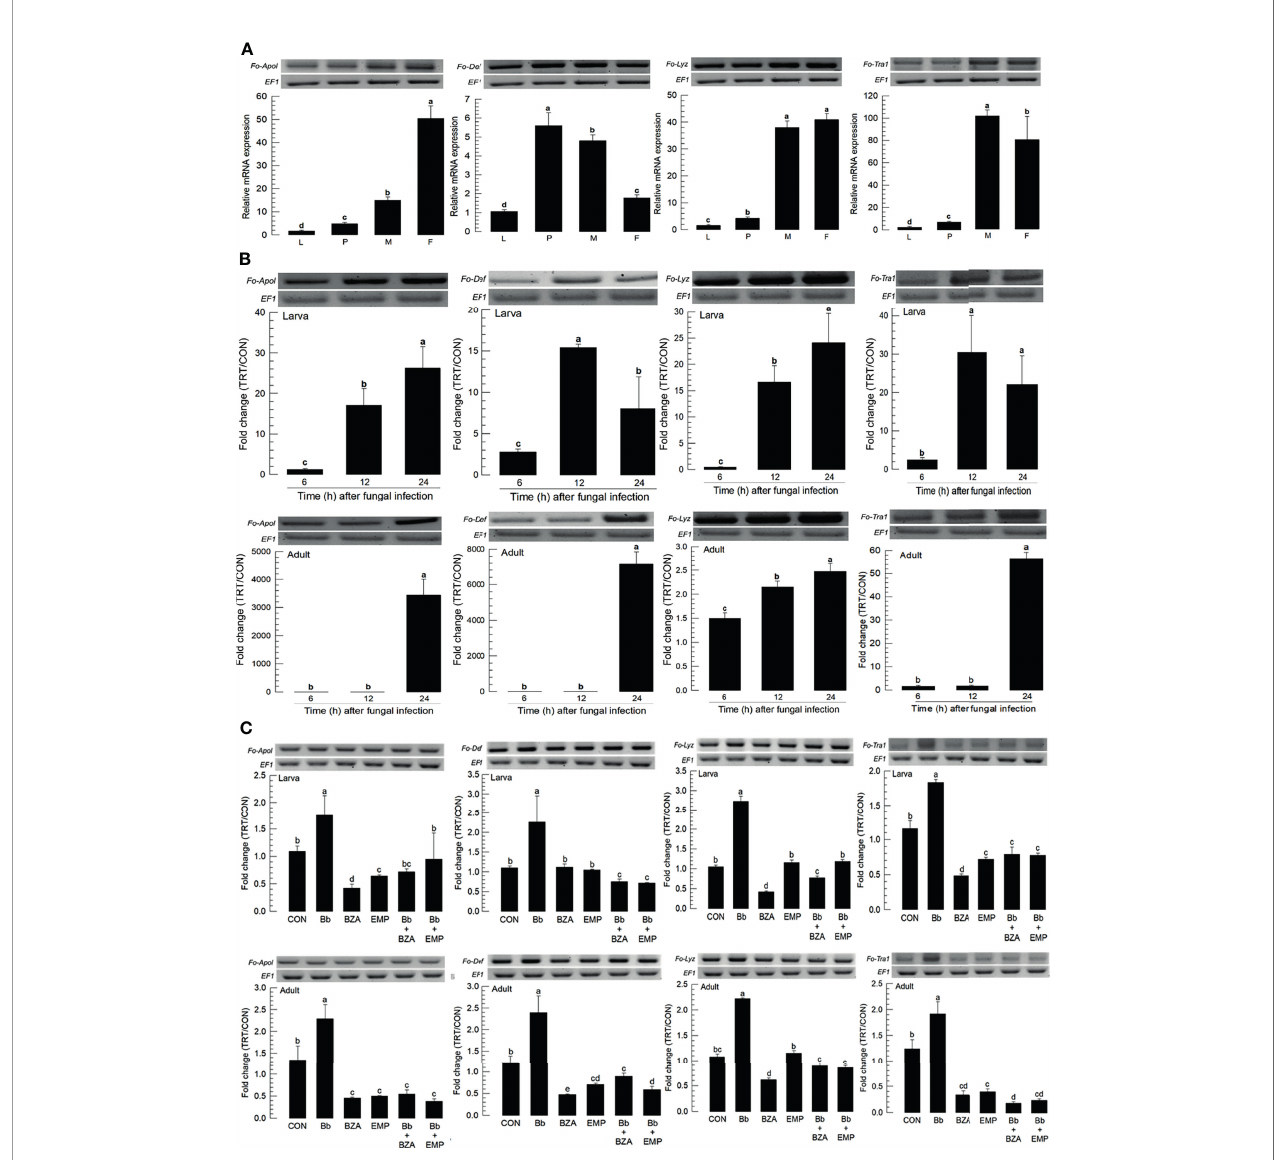
FIGURE 9 | Inhibitory effect of EMP or BZA on the expression of four antimicrobial peptides (AMPs) in F. occidentalis named as Fo-Apol (apolipophorin III), Fo-Def (Defensin), Fo-Lyz (lysozyme), and Fo-Tra1 (transferrin 1). (A) Expression of four AMPs in different developmental stages of larva ( ‘ L ’ ), pupa ( ‘ P ’ ), male ( ‘ M ’ ), and female ( ‘ F ’ ) adult. RNA samples were collected from the whole body extracts of larvae (~100), pupae (~100), or adults (~100) for each treatment. (B) Inducible expression of four AMPs in L2 larvae or adults upon a fungal challenge with Beauveria bassiana (1×10 6 conidia/mL) at different time points. (C) To check this immunosuppressive activity, B. bassiana (1×10 5 conidia/mL) along with EMP (1,000 ppm) or BZA (1,000 ppm) were used in the way mentioned previously. RNA samples were collected from the whole body extracts of larvae (~100) or adults (~100) for each treatment after 24 h of post-infection. The expression of an endogenous gene, EF1 , con fi rms the equal gel loading and the integrity of the cDNA preparation. Each measurement was replicated three times. Fold changes are calculated by ratios of expression levels of immune-challenges ( ‘ TRT ’ ) over naïve ( ‘ CON ’ ) thrips. Different letters above standard deviation bars indicate signi fi cant differences among means at Type I error = 0.05 (LSD